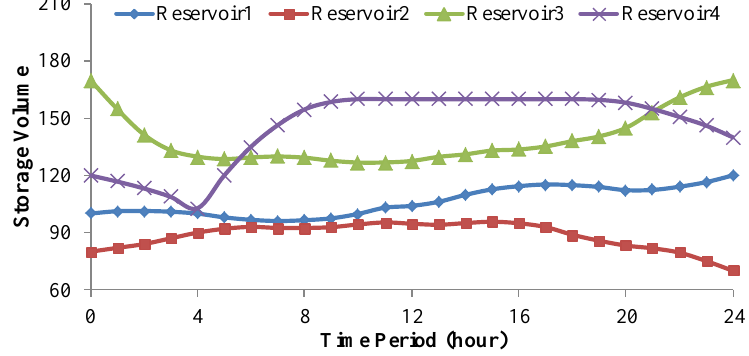
Figure 8. The water storage processes of Scheme 15 by PMOGA for Case 1. Table 2. The detailed results of scheme 15 by PMOGA for case 1.